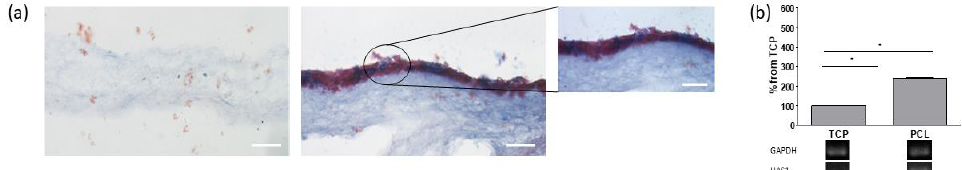
Figure 4. ( a ) Alcian blue staining of cultures grown on PCL at 7 days from seeding. Image on the left shows PCL scaffold without cells, whereas images on the right report PCL-based cultures. Mucopolysaccharides stain blue, and cytoplasm red. Bars: 100 and 50 µ m. ( b ) RT-PCR analysis of HAS1 of cultures grown on tissue-culture polystyrene (TCP), and PCL scaffolds at 7 days from seeding. Quantification of transcript levels was carried out by densitometric analysis using ImageLab software. Data were reported as the percentage from TCP taken as 100. * p < 0.05 vs. TCP cultures; Student’s t test.